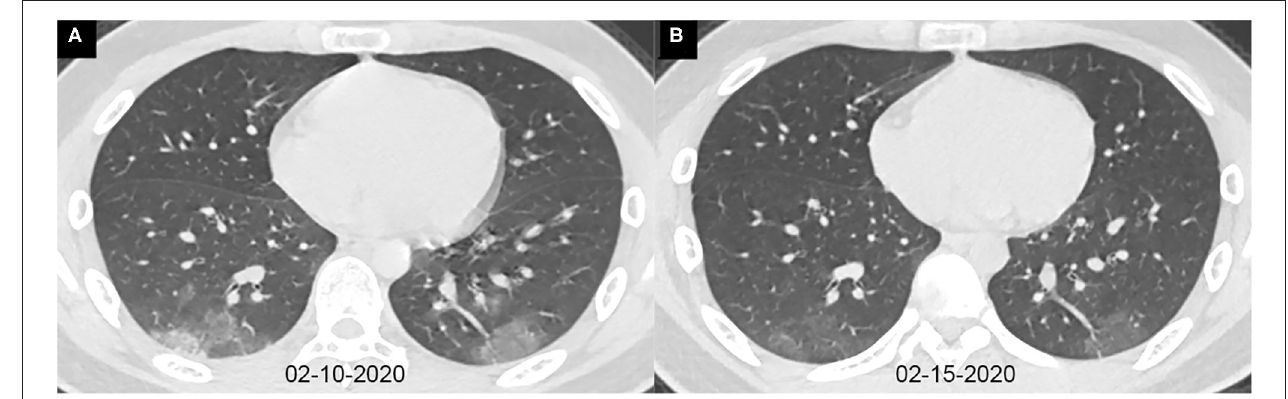
FIGURE 2 | Axial chest CT images of a 13-year-old boy with fever and cough for 10 days. Pharyngeal swab RT-PCR tests were performed on February 4, 5, and 16, 2020, with positive results, and on February 20 and 21, 2020, with negative results. Chest CTs were obtained on February 10 (A) and 15 (B) . (A) The typical ground-glass opacities are shown in the bilateral lower lobes. (B) The ground-glass opacities are obviously absorbed.